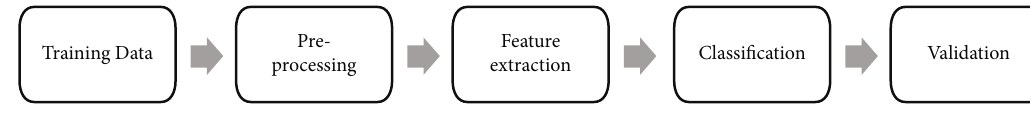
Figure 1: Proposed Model.